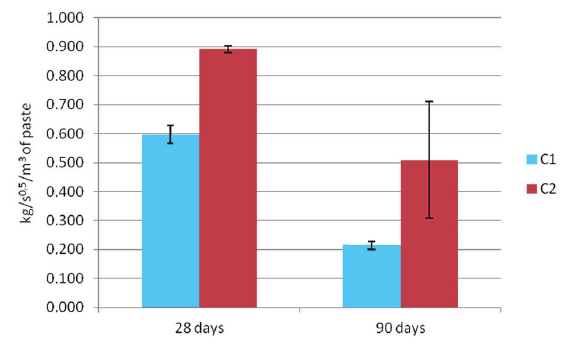
Fig. 5. Sorptivity change in time of C1 and C2 concrete mixtures normalized by paste content by volume